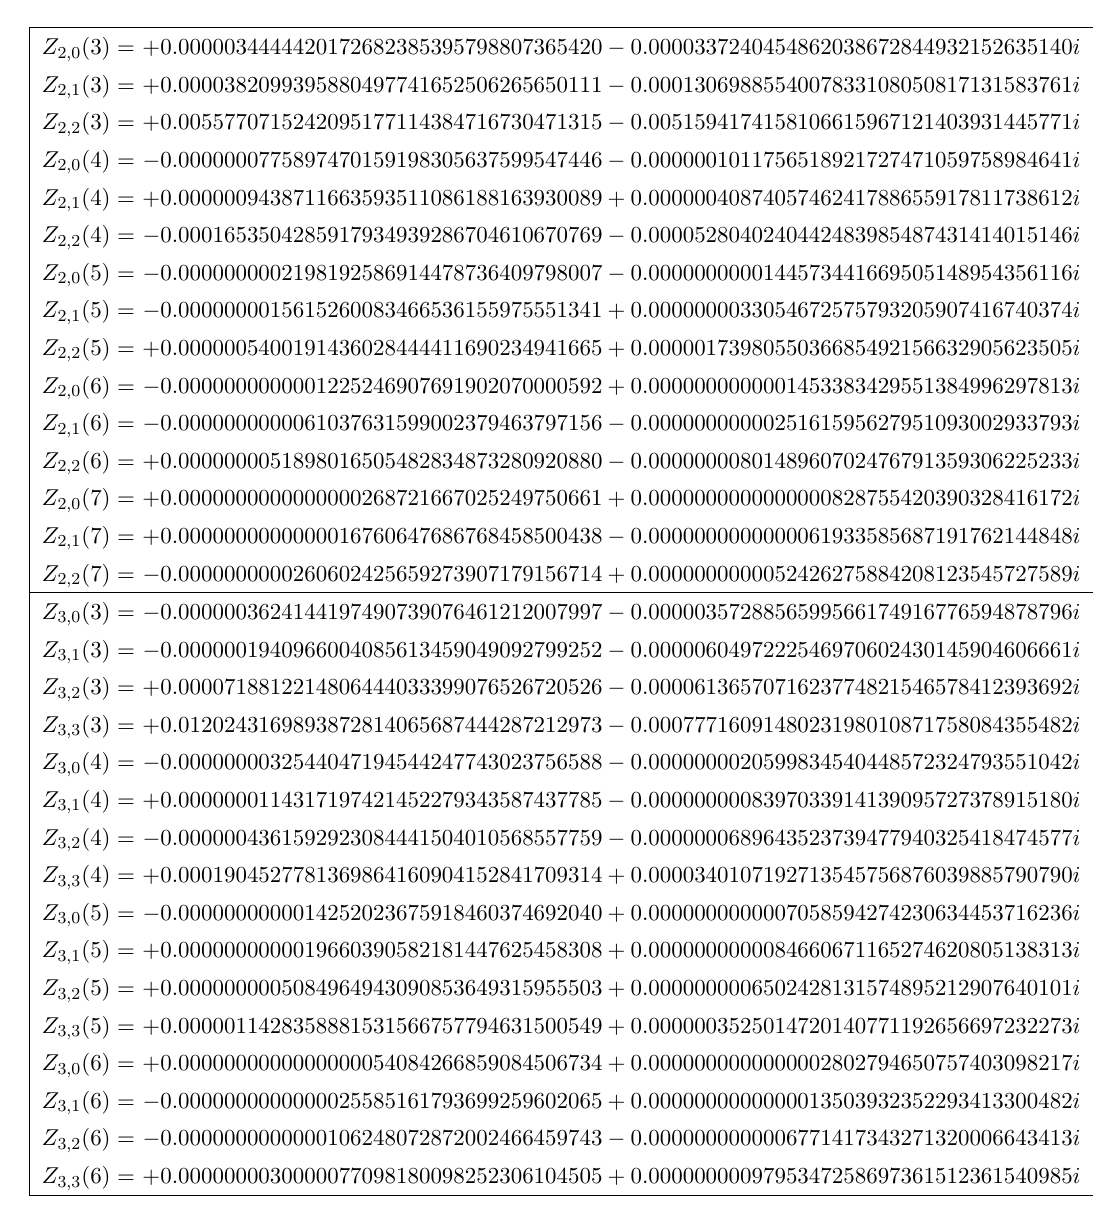
Table 1 . Exact values of Z k,M ( N, m 1 , m 2 ) for a generic complex value of m 1 = m 2 which we √ √ have chosen as m 1 = m 2 = ( 2 + 3 i ) / 2 . Together with the exact values of Z k,M ( N, m 1 , m 2 ) for N = 1 , 2 in appendix B.1, the displayed digits of the numerical values of Z k,M ( N, m 1 , m 2 ) for N ≥ 3 are sufficient for checking the bilinear relation (3.1) at order ∼ 10 − 35 which is smaller